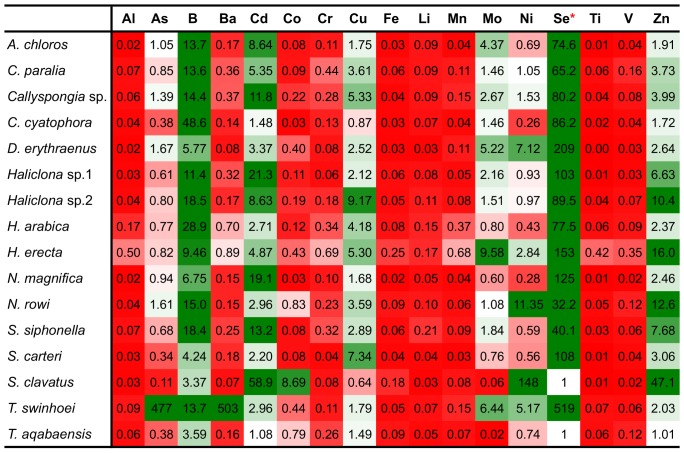
BCFs of all studied metals in Red Sea sponges.Green indicates BCF>1 (darker shades signify higher BCF) and red indicates BCF<1 (darker shades signify lower BCF). * Lowest detection value of ICP setup substituted for missing Se value in sediment, S. clavatus and T. aqabaensis.